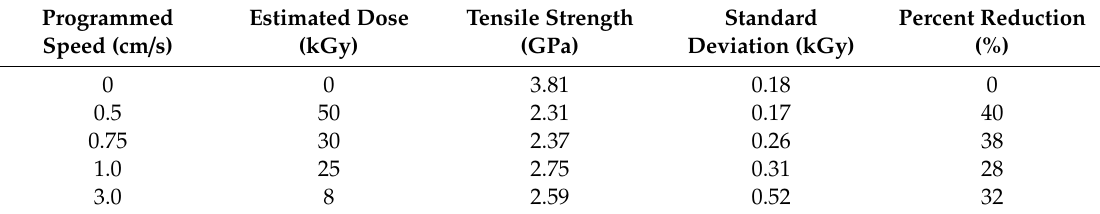
Figure 8. Breaking strength of irradiated UHMMPE fibers as a function of dose. Table 1. The effect of irradiation on tensile strength for UHMMPE fibers irradiated using the electron beam.